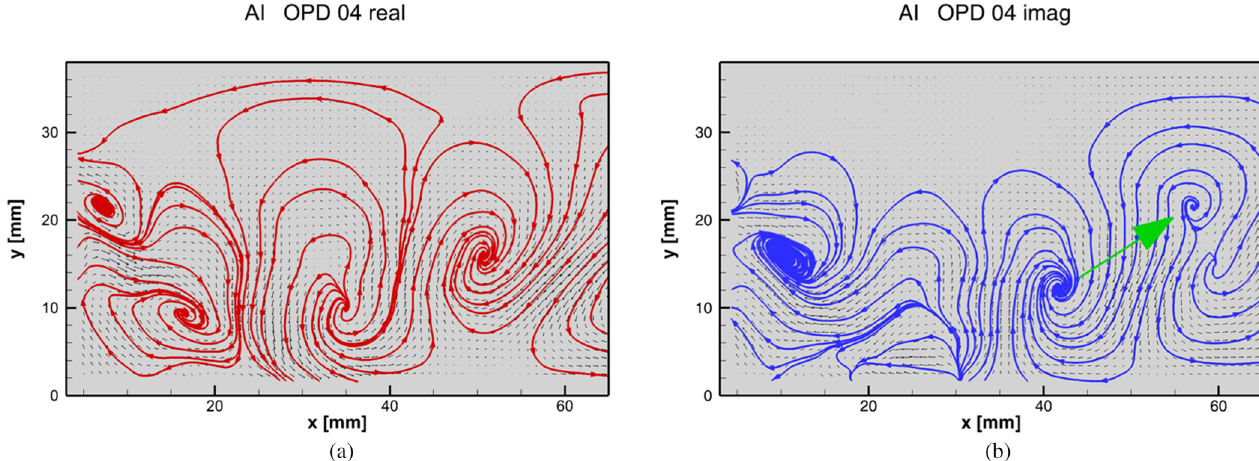
Fig. 13. Topology of the OPD mode no. 4 in the branch A, zone I, real (a) and imaginary (b) parts.